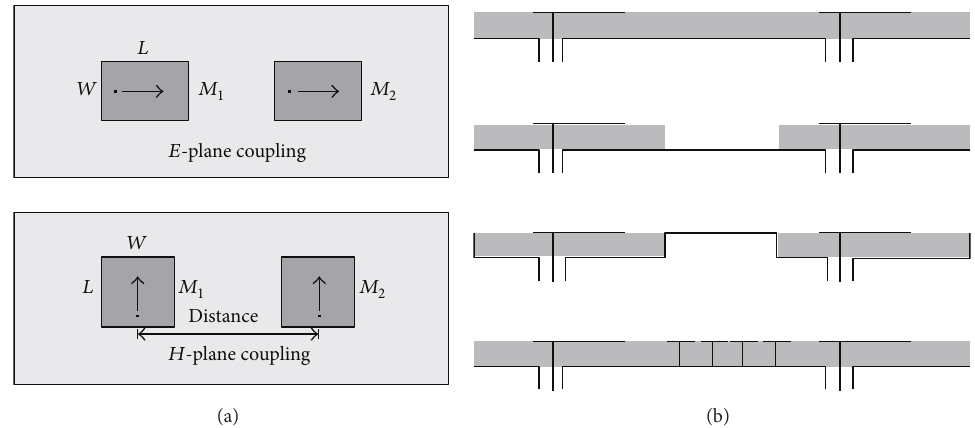
Figure 23: (a) The coupling direction in probe fed microstrip antenna arrays. (b) Techniques to reduce mutual coupling: normal microstrip array, substrate removal, cavity backing, and EBG structures (from top to bottom).